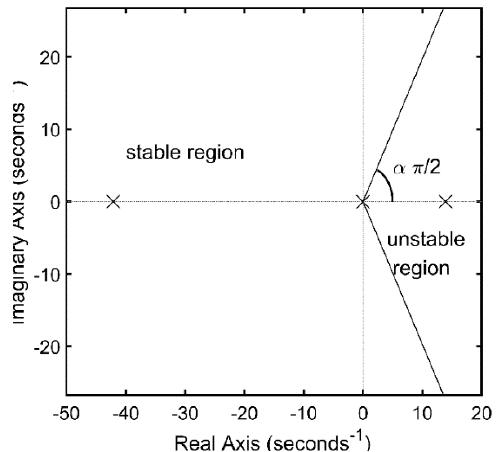
Figure 5. Stability region of the FOM with α = 0.85.